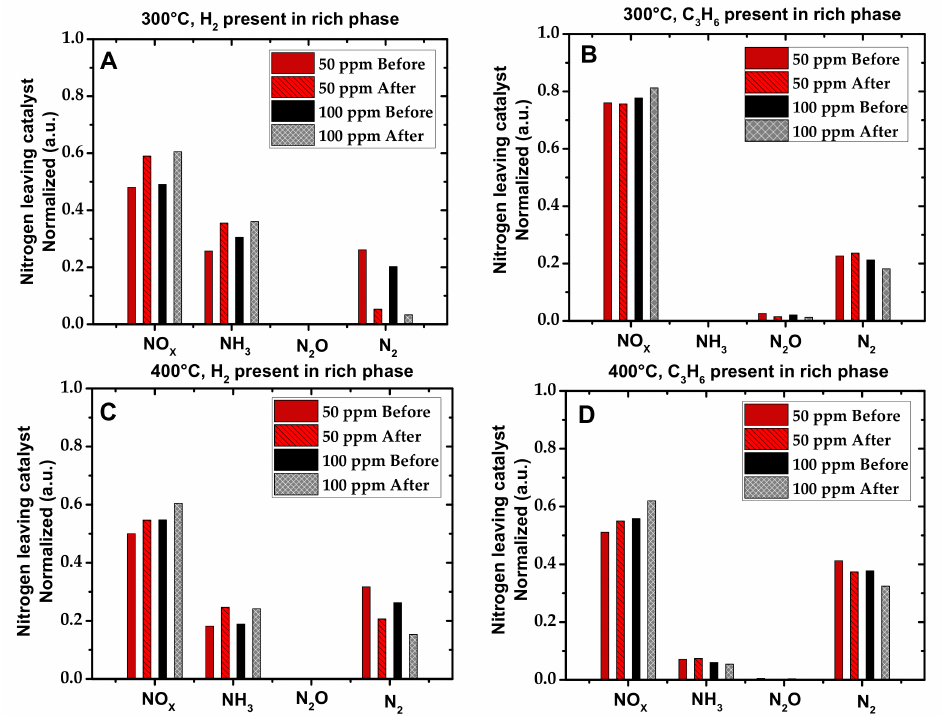
Figure 5. Balance over outlet nitrogen atoms over a lean/rich cycle before and after exposing Pt/Ba/Al 2 O 3 to 50 and 100 vol.-ppm H 3 PO 4 for 34 h, assuming that all nitrogen leaving the catalyst is either in form of NO x , NH 3 , N 2 O or N 2 . ( A ) 300 ◦ C with 1 vol.-% H 2 in the rich phase, ( B ) 300 ◦ C with 0.1 vol.-% C 3 H 6 in the rich phase, ( C ) 400 ◦ C with 1 vol.-% H 2 in the rich phase, ( D ) 400 ◦ C with 0.1 vol.-% C 3 H 6 in the rich